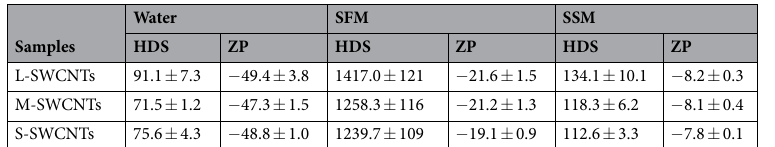
Table 1. Hydrodynamic Size (HDS, nm) and Zeta Potential (ZP, mV) of L, M, and S-SWCNTs in water, serum- free medium (SFM), serum-supplemented medium